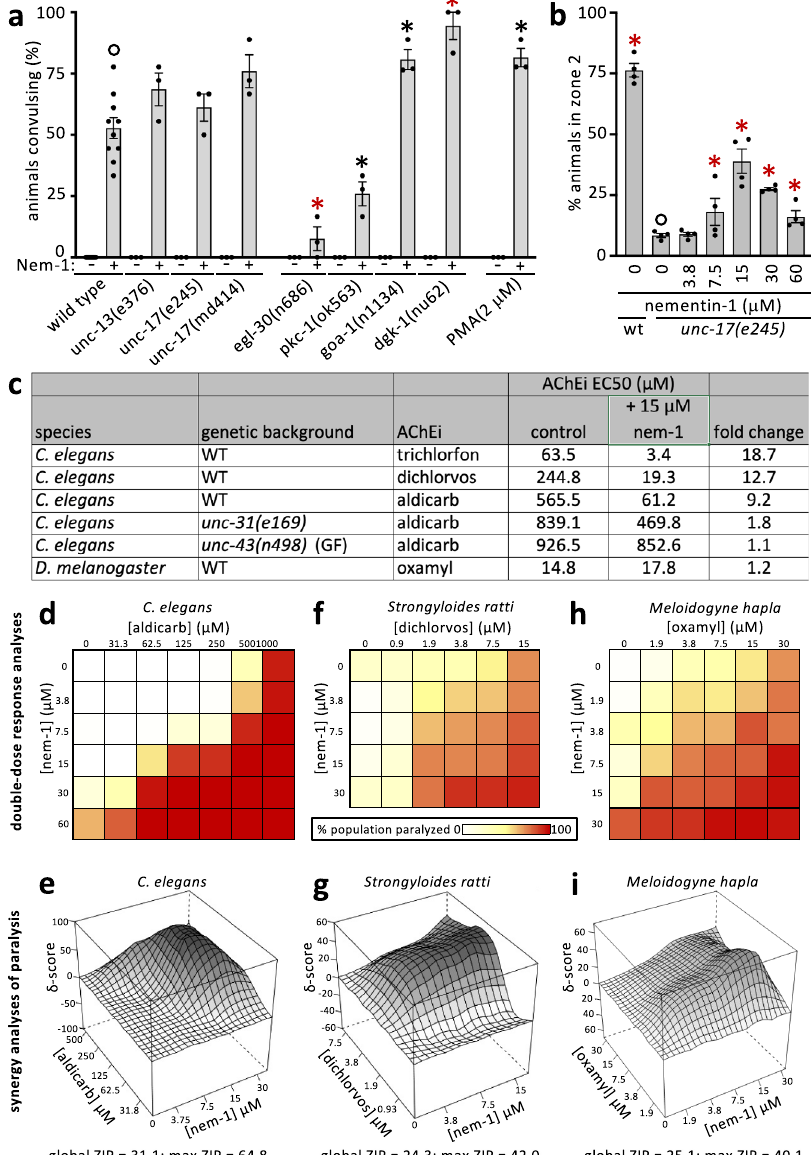
Fig. 5 Nementin enhances AChE-inhibitor activity via DCV release. a Convulsions induced after 80 min of exposure to nementin-1 (Nem-1) (60 μ M) or vehicle control in the background of the indicated mutant gene, or in the background of 24 h of preincubation with the DAG memetic PMA. Showing the mean and SEM of n = 3 biologically independent trials ( n = 10 for 60 μ M wild-type) measuring 18 animals per trial. b The ability of wild type (WT) or unc- 17 mutant animals to productively locomote to zone 2 over 180 min after being placed in the center of a plate (see schematic in Fig. 3b) in the indicated nementin concentration. Showing the mean of n = 4 biologically independent trials with ~150 animals per trial. For both A and B, black asterisk p < 0.01, red asterisk p < 0.001, Bonferroni corrected Chi-square test of independence relative to control (open circle); SEM is shown. c Acetylcholinesterase inhibitor (AChEi) EC50s for different species and genetic backgrounds. Oxamyl is the only AChEi tested that exhibited activity against fl ies. EC50s are generated from a concentration series tested over n = 3 biologically independent trials scoring 18 animals per condition. d , f , and h Double dose-response analyses of nementin-1 ( y -axis) vs the indicated AChEi ( x -axis) in the indicated nematode species. The scale for the percentage of the population paralyzed applies to d – f . Each concentration was tested over n = 3 biologically independent trials for elegans with 18 animals within each trial, n = 6 trials for ratti with ≥ 30 animals within each trial, n ≥ 3 trials for hapla with ≥ 15 animals within each trial. e , g , and i The corresponding zero-interaction potency (ZIP) synergy score heatmaps for the double dose-response analyses presented in d – f . Max ZIP-score is de fi ned as the maximal ZIP-score obtained from a combination of three concentrations of each compound in the double dose response. Shading highlights the topology of the plot and differs between g – i . Primary data for this fi gure can be found in Supplementary Data Cholinergic enhancement is a secondary effect of DCV phospholipases 33 (Fig. 4c). By contrast, the G α o protein GOA-1 release . Neuropeptides released from DCVs are known to reduces DAG abundance by triggering its phosphorylation by interact with G-protein coupled-receptors (GPCRs) that signal diacylglycerol kinase DGK-1 34 . Neuronal DAG primes both DCV and SV release via interaction with PKC-1(PKC- ε / η ) 35 through G-proteins 32 . In C. elegans neurons, the G α q protein and UNC-13 36 , respectively. The bioamines and neuropeptides EGL-30 stimulates DAG production via the EGL-8 and PLC-3